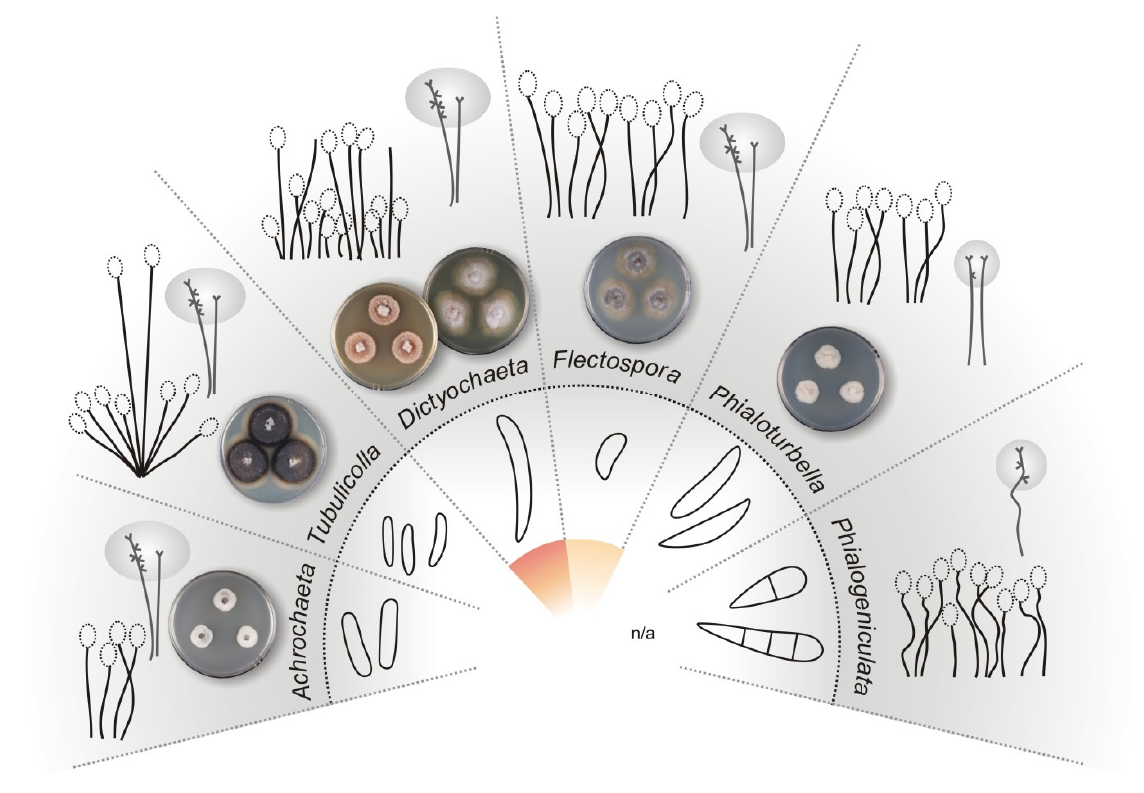
Figure 47. Morphotypes of Dictyochaeta and similar genera with non-setulate conidia. Legend as in Figure 46.